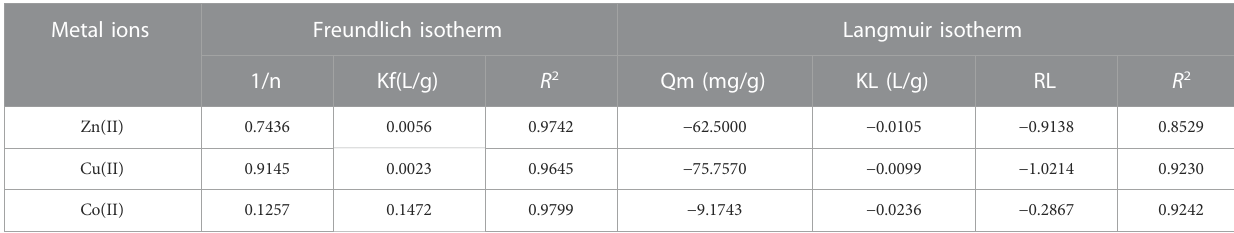
TABLE 1 Parameters for Freundlich and Langmuir isotherms (aqueous samples). Metal ions Freundlich isotherm Langmuir